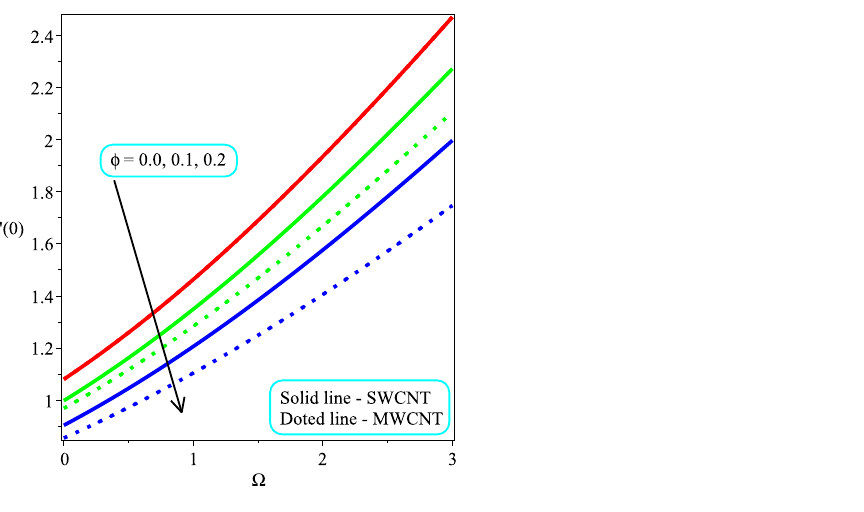
Figure 12. Repercussion of φ with κ = 2, ω = π /3, M egt = 1 on the local skin friction field.